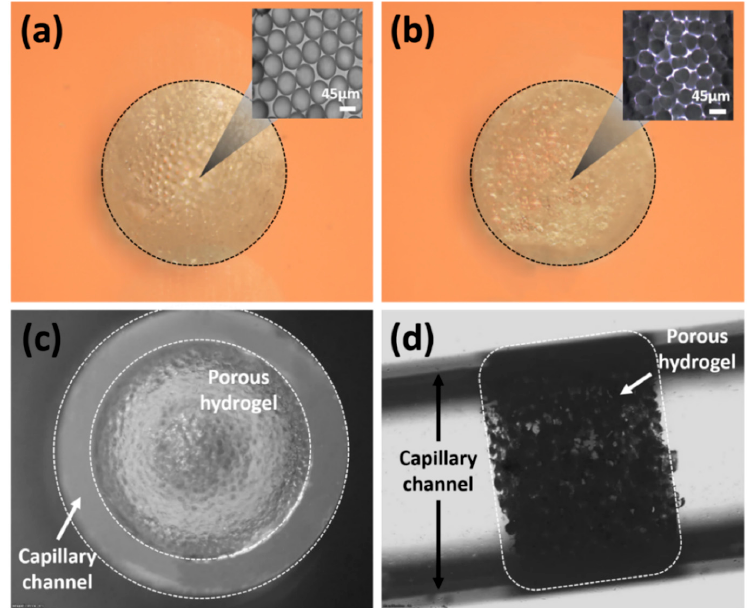
Figure 4. Microscope image of porous hydrogel (image scale 500 µm): ( a ) hydrogel filled the spaces of the self-assembled particles and closely-packed colloidal structure; ( b ) porous hydrogel after the removal of the template and the microstructure of the porous hydrogel; ( c ) frontal view of the porous hydrogel inside the capillary channel; ( d ) side view of the porous hydrogel inside the capillary channel.